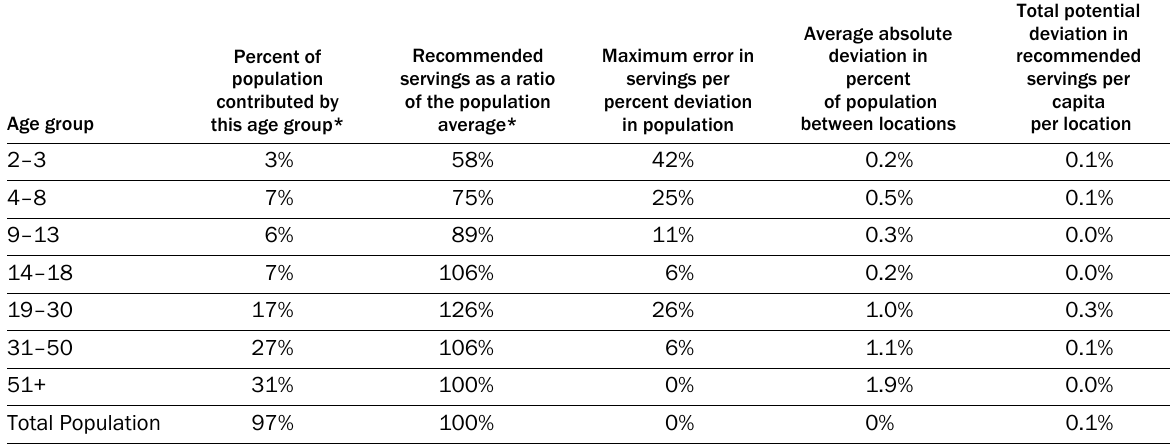
Table 5. Expected Deviations in Foodshed Demand by Age Group